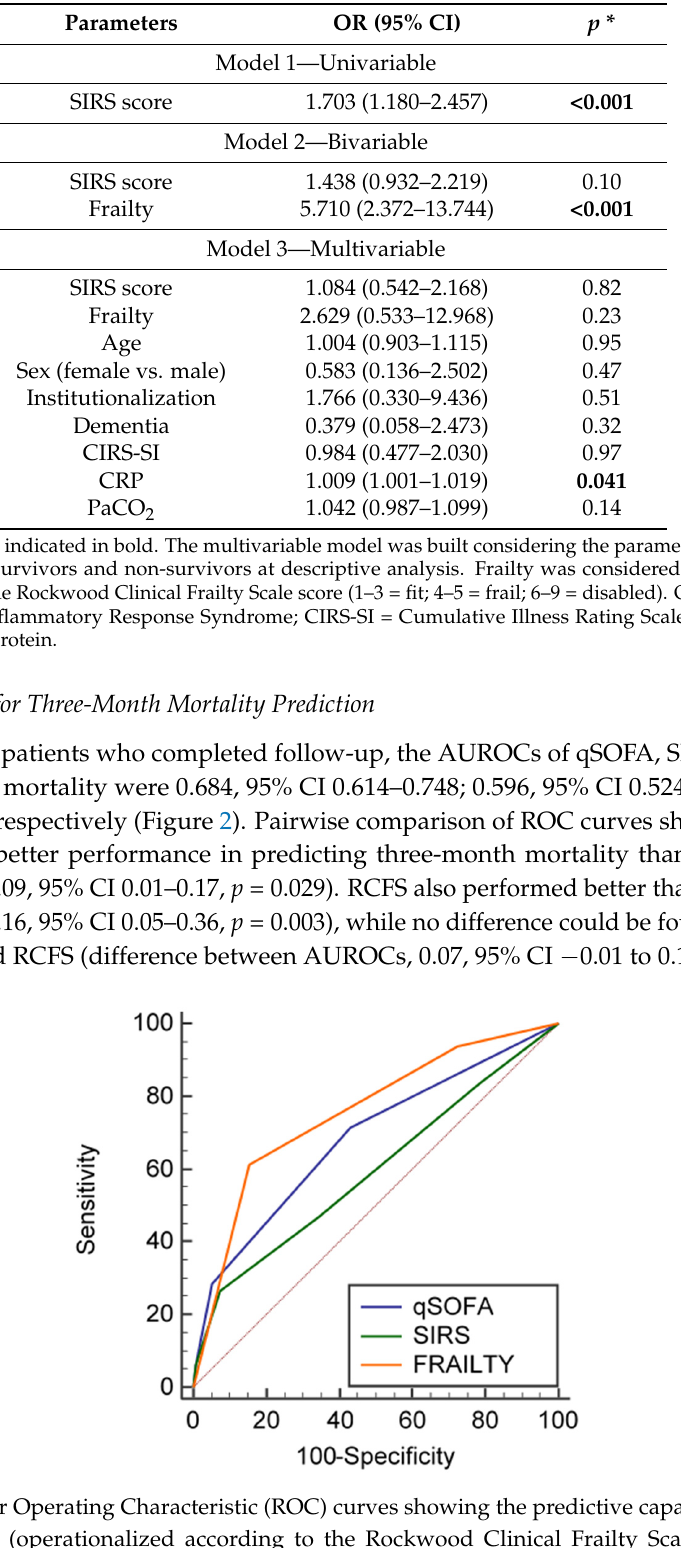
Table 3. Logistic regression analysis showing the association of SIRS score at admission with the primary study outcome (in-hospital mortality) in elderly patients with suspected sepsis ( n = 272).